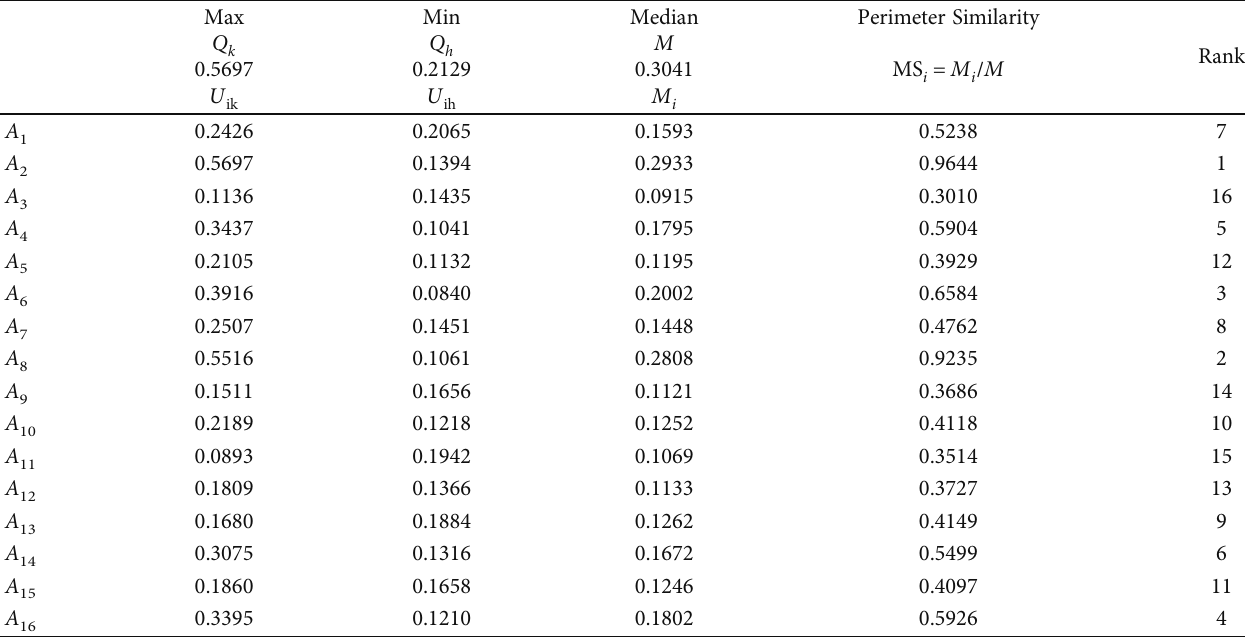
Table 9: Alternatives ranked according to RAMS method.